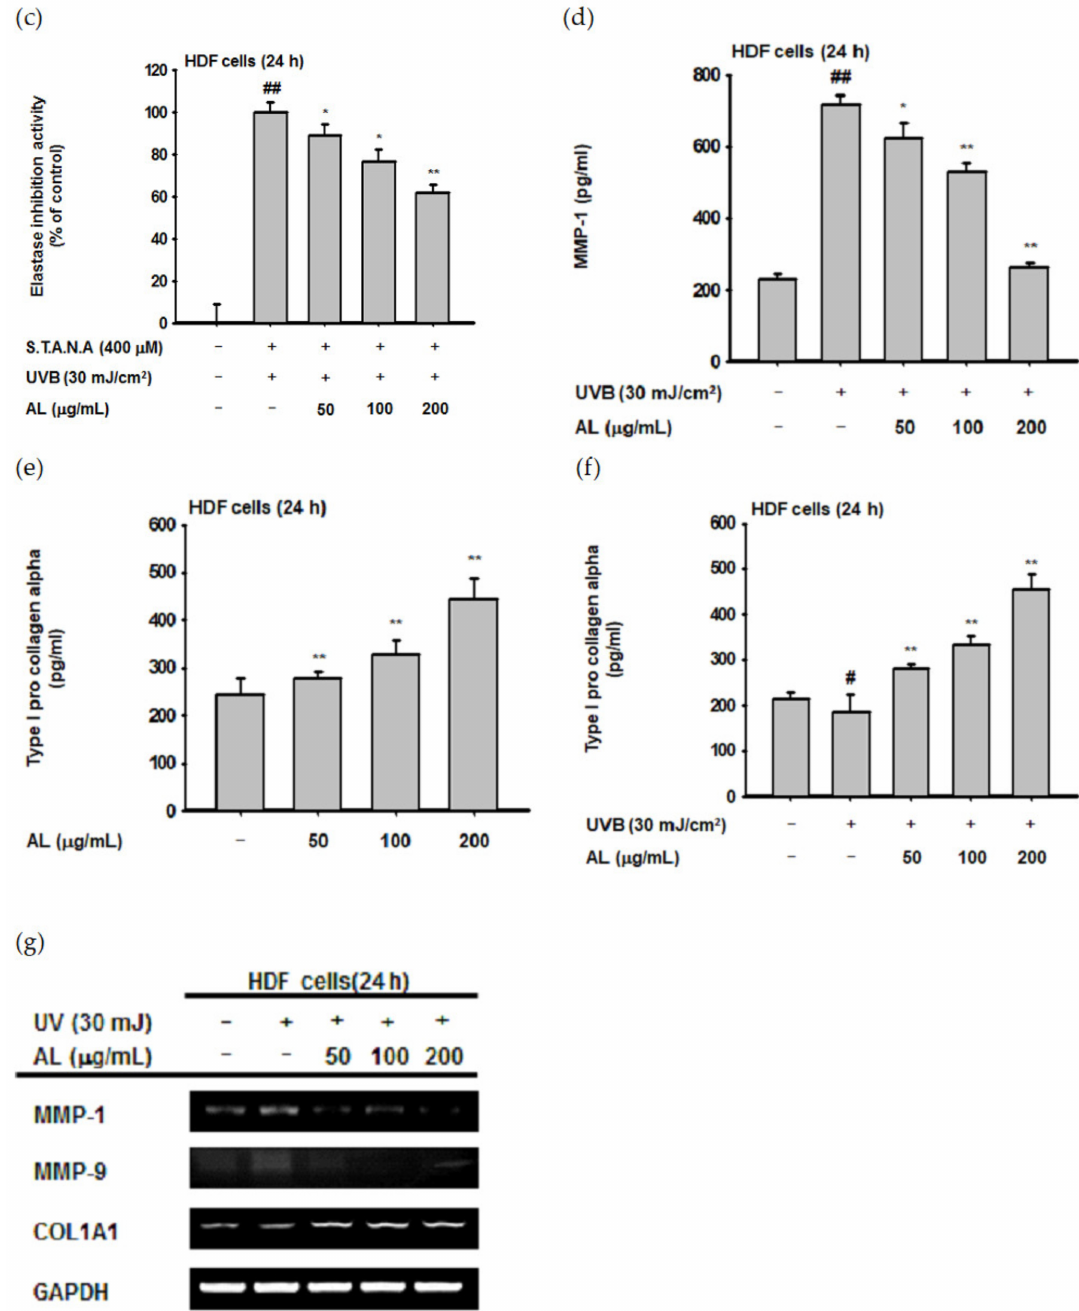
Figure 3. Antiwrinkle e ff ects of AL in human dermal fibroblast cells. ( a and b ) Viability of human dermal fibroblast (HDF) cells treated with the indicated dose of AL (50–200 µ g / mL) for 24 ( a ) or 48 h ( b ) was measured using the MTT assay. ( c ) Elastase inhibition activity of AL (50–200 µ g / mL) in UVB-irradiated HDF cells was measured using STANA (400 µ M). ( d ) MMP-1 expression was measured using ELISA in human dermal fibroblast cells treated with AL (50–200 µ g / mL) following UVB irradiation. ( e and f ) Type 1 procollagen alpha expression was measured using ELISA in human dermal fibroblast cells treated with AL (50–200 µ g / mL) without ( e ) and with ( f ) UVB irradiation. ( g ) The mRNA expression of MMP-1, MMP-9, and COL1A1 in HDF cells treated with AL (50–200 µ g / mL) were determined using RT-PCR. + : indicate treatment, − : indicate non-treatment. For all applicable experiments, statistical significance was evaluated using the Mann–Whitney U test. # p < 0.05 and ## p < 0.01 compared with the normal group, and * p < 0.05 and ** p < 0.01 compared with the control